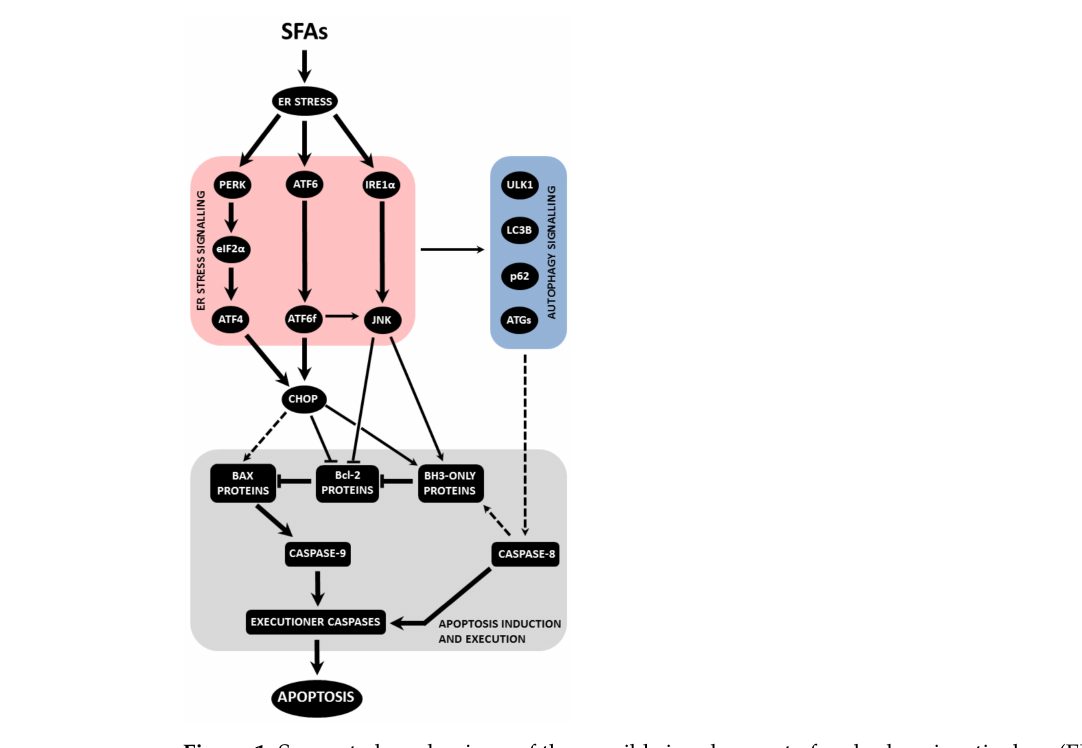
Figure 1. Suggested mechanisms of the possible involvement of endoplasmic reticulum (ER) stress and autophagy signalling in apoptosis induced by saturated fatty acids (SFAs) in pancreatic β -cells. Thick lines mean strong support of the respective relationship by available data, while thin lines mean weaker support. Dashed lines show a relationship proved only in other cell types.